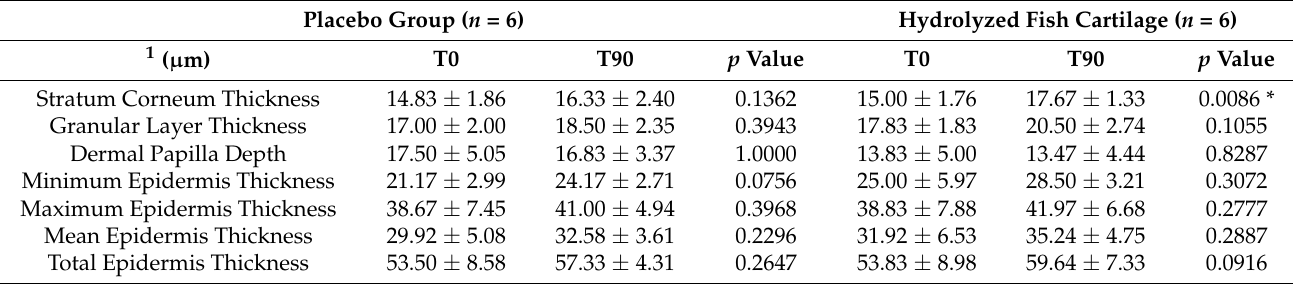
Table 1. Reflectance confocal microscopy (RCM) parameters of epidermis thickness. Placebo Group ( n =